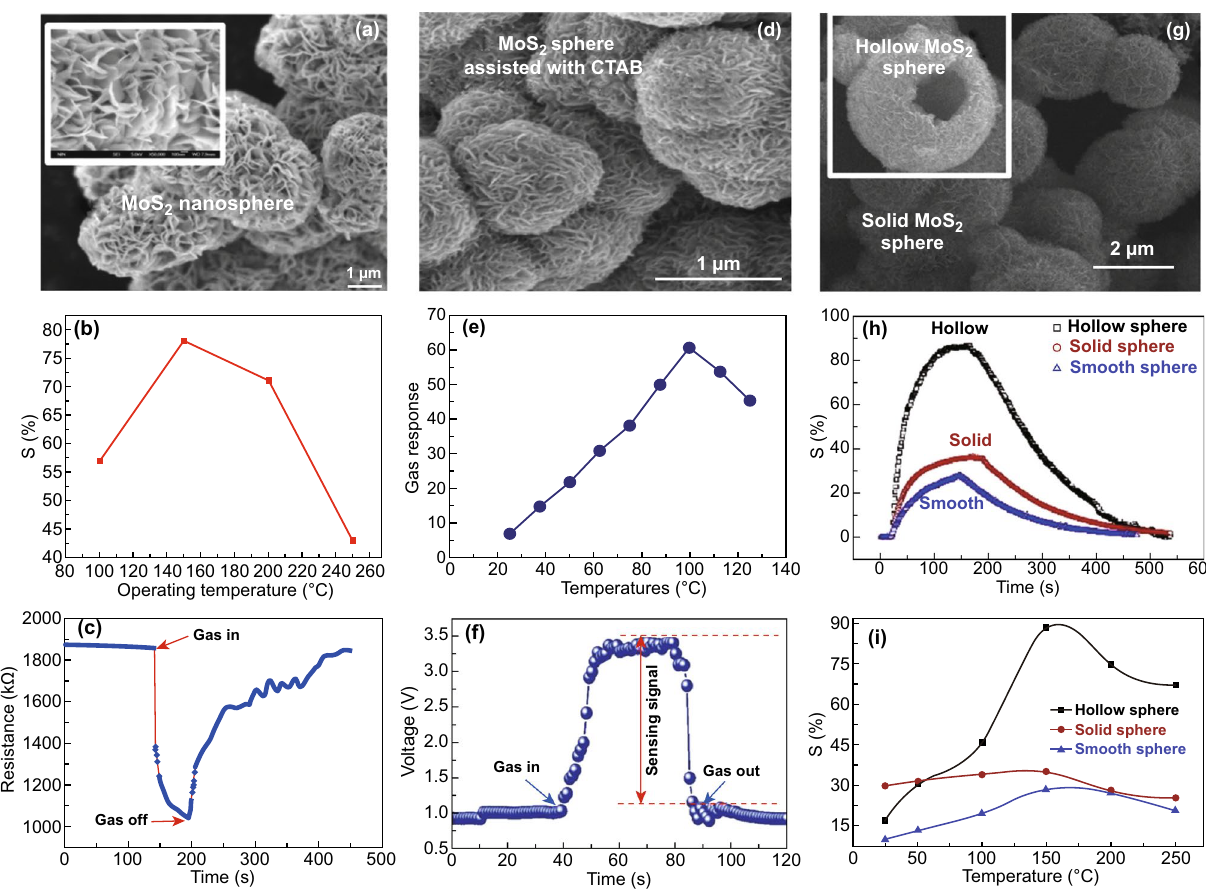
Fig. 13 a FESEM image of the MoS 2 nanosphere. b Sensor response profile. c Transient resistance profile. Reproduced with permission from Ref. [33]. Copyright (2016) from Elsevier. d FESEM image of the CTAB-assisted MoS 2 sphere. e Gas response obtained at different temperature range. f Time response profile of NO 2 sensing. Reproduced with permission from Ref. [306]. Copyright (2018) from Elsevier. g FESEM image of solid MoS 2 sphere and hollow sphere. h Obtained sensor response for hollow, solid and smooth spheres. i Sensor response at different tem- peratures. The highest sensor response obtained for the hollow spheres. Reproduced with permission from Ref. [307]. Copyright (2019) from